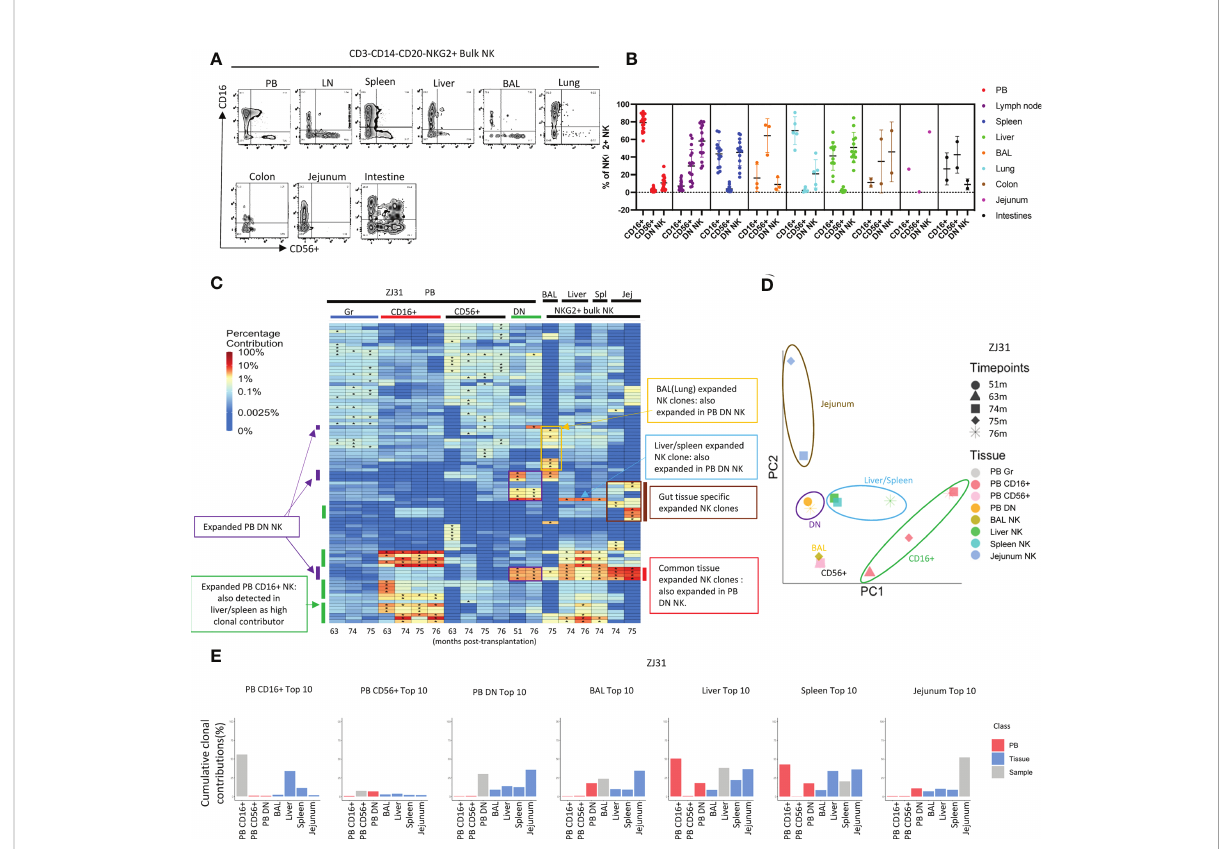
FIGURE 4 Natural killer cell clonality analyses in blood and tissues (A) Representative fl ow cytometric analysis of CD16 and CD56 expression within PB and tissue NKG2+ NK cells. (B) Summary of the distribution of NKG2+ NK cell subsets based on CD16 and CD56 expression in blood and tissues. DN- “ double negative ” for both CD16 and CD56 expression. Individual samples shown as individual dots. (C) Heat maps of the natural log fractional abundance of the highest contributing clones de fi ned as all barcodes present as a top 10 highest contributing barcode in at least one of the PB granulocyte (Gr), PB NK cell subsets, or tissue bulk NKG2A+ NK cells puri fi ed from tissues collected from animal ZJ31 at the designated time points, mapped over all samples for the animal. Heatmaps were constructed as in Figure 2A. The biased/expanded PB NK subset clones were de fi ned as 5 folds expanded in a speci fi c PB NK subset compared to other PB NK subsets and PB Gr. The tissue speci fi c biased/expanded NK clones were de fi ned as 5 folds expanded in a speci fi c tissue NK population compared to all other NK populations in other locations. Jej-jejunum;